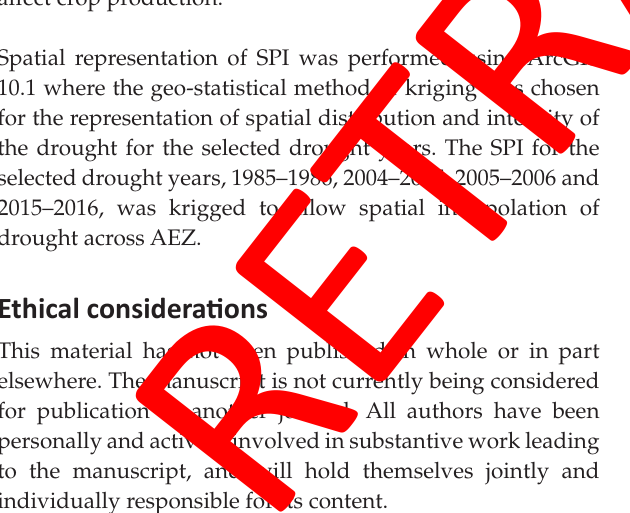
as one of the worse to occur in 50 years (Phys.org 2016).